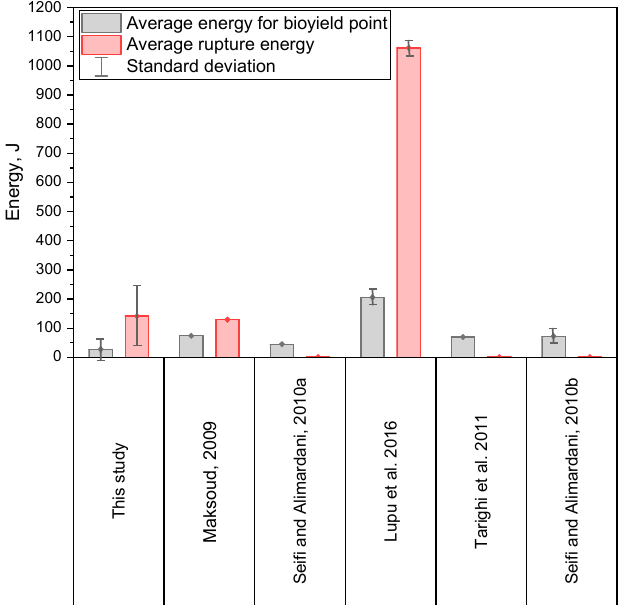
Figure 10. Results of average values of the energy obtained in this study compared to the previous study.